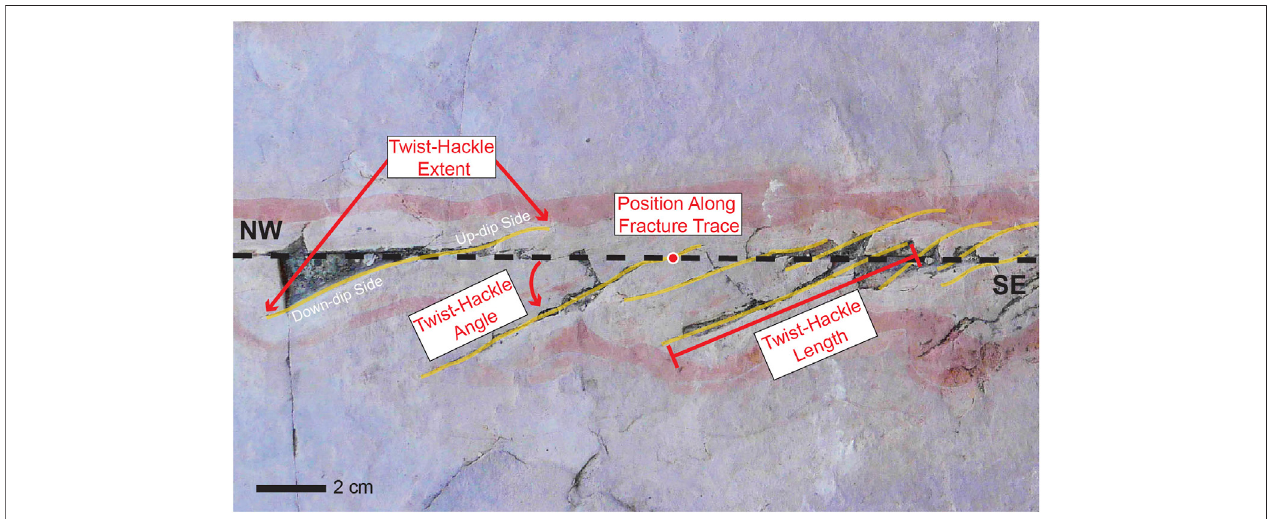
FIGURE 8 | Outcrop photograph of twist hackles in map-view on Pavement 1, Fracture 12. The fracture trace is shown with the dashed black line, the position alongthefracturetrace,thetwist-hacklelength,thetwist-hackleangle,whichinthiscaseiscounter-clockwise,andthetwist-hackleextent, whichisonbothsidesofthe fracture trace in this case, are all labeled and shown in